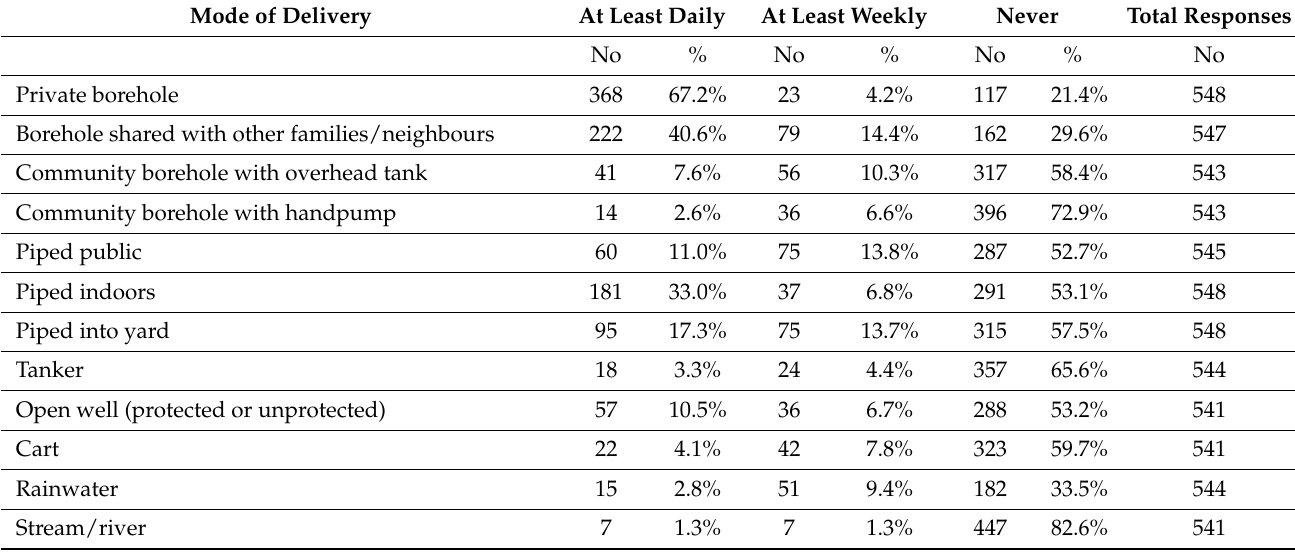
Table 2. Capstick Survey data—how often do you use the following sources of water? (Lagos State). Mode of Delivery